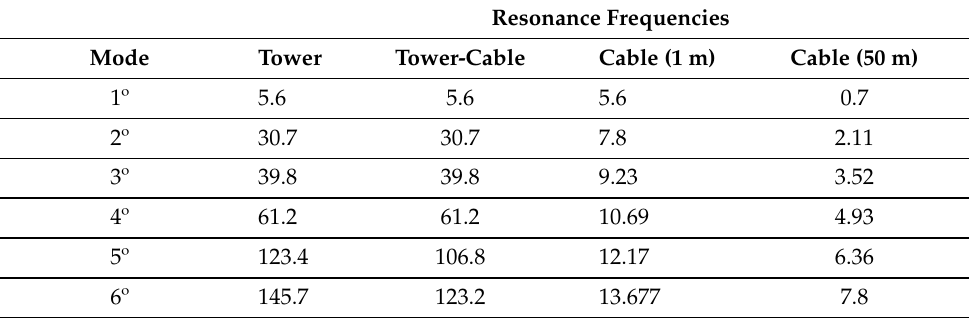
Table 6. OTL and components resonance